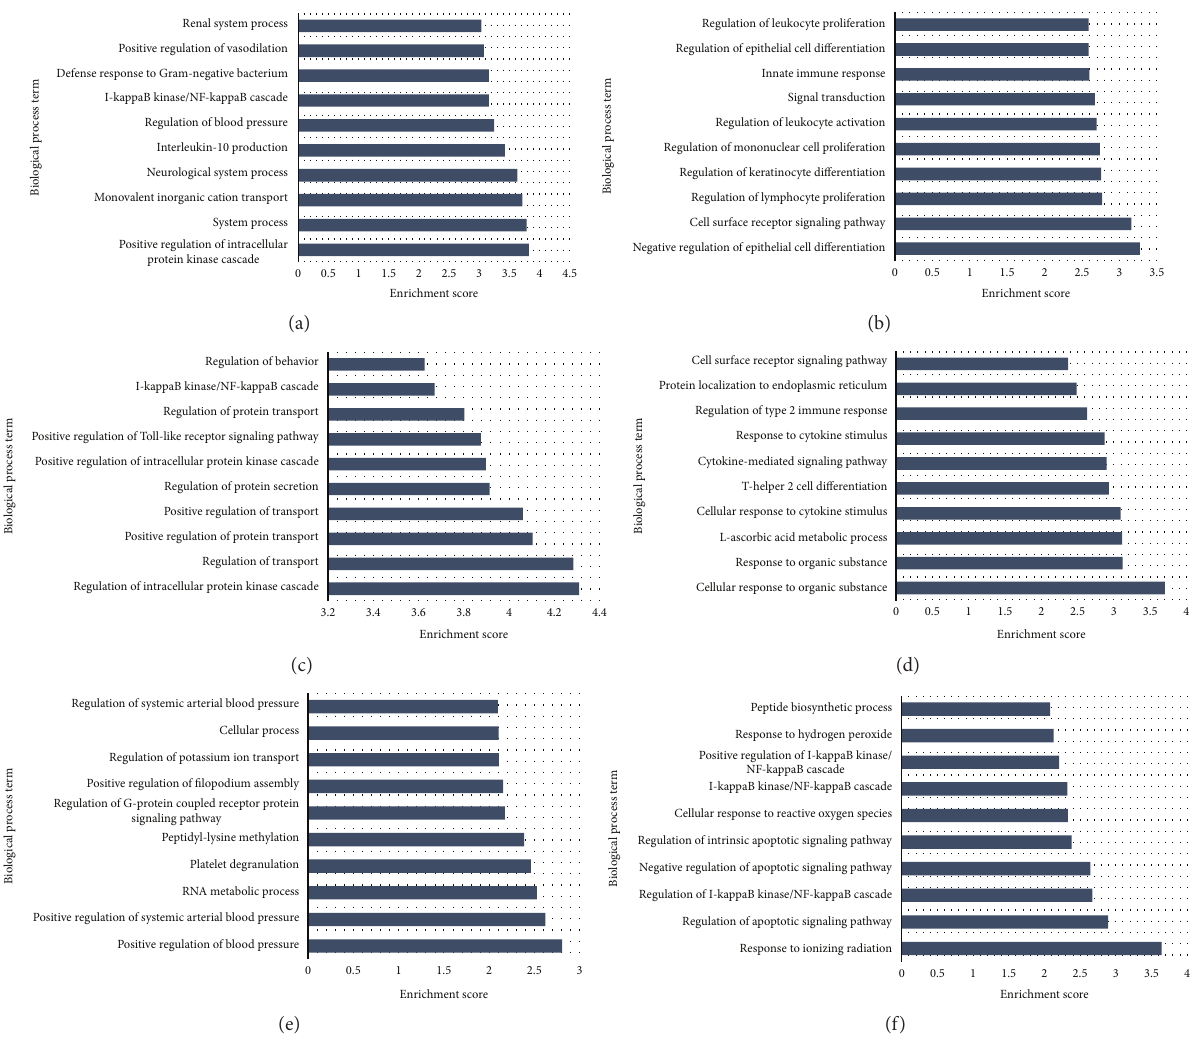
Figure 3: GO analysis of the differentially methylated genes in diabetes, prediabetes, and controls. The bars plot shows the top ten enrichment score values of the significant enrichment terms. X -axis: GOID’s enrichment score value; it equals − log 10( P value); Y -axis: GO category. (a) Hypomethylated diabetes versus controls. (b) Hypermethylated diabetes versus controls. (c) Hypomethylated diabetes versus prediabetes. (d) Hypermethylated diabetes versus prediabetes. (e) Hypomethylated prediabetes versus controls. (f) Hypermethylated prediabetes versus